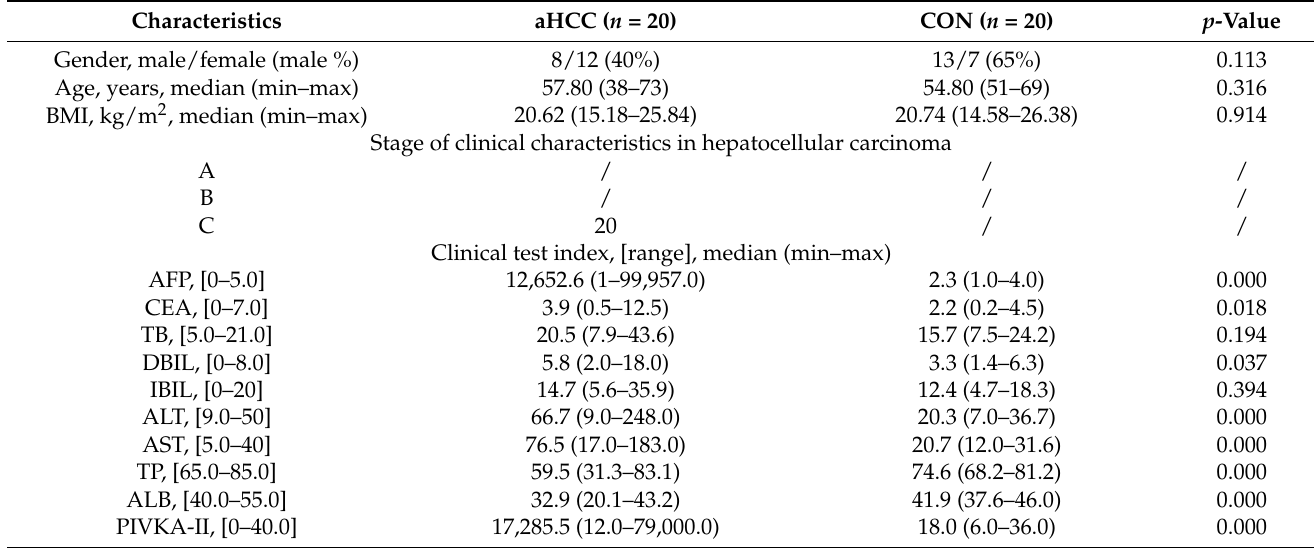
Table 1. Clinical characteristics of patients with advanced hepatocarcinoma (aHCC) and healthy individuals (CON) in this